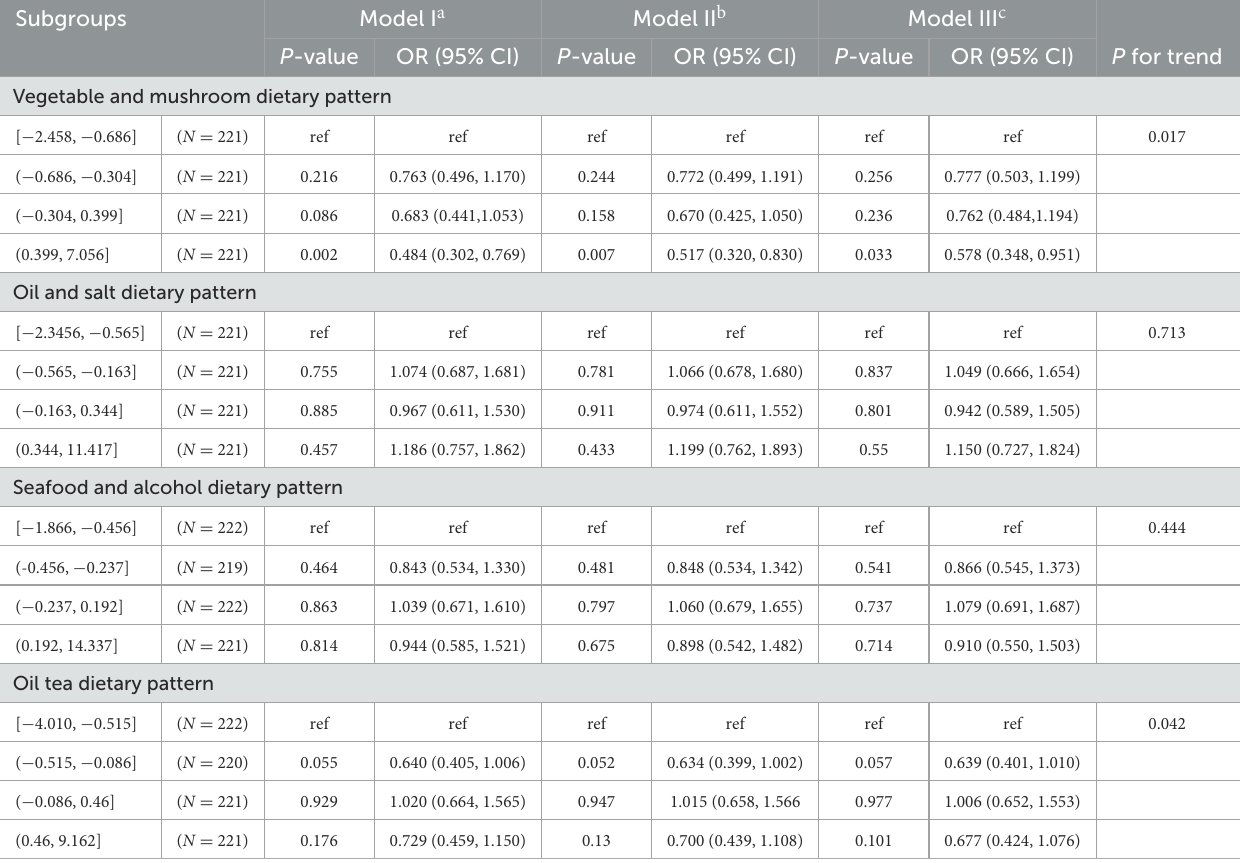
TABLE 6 Different potential confounders entered the logistic regression model and participants adhered to the relationship between different dietary patterns and cognitive functioning.